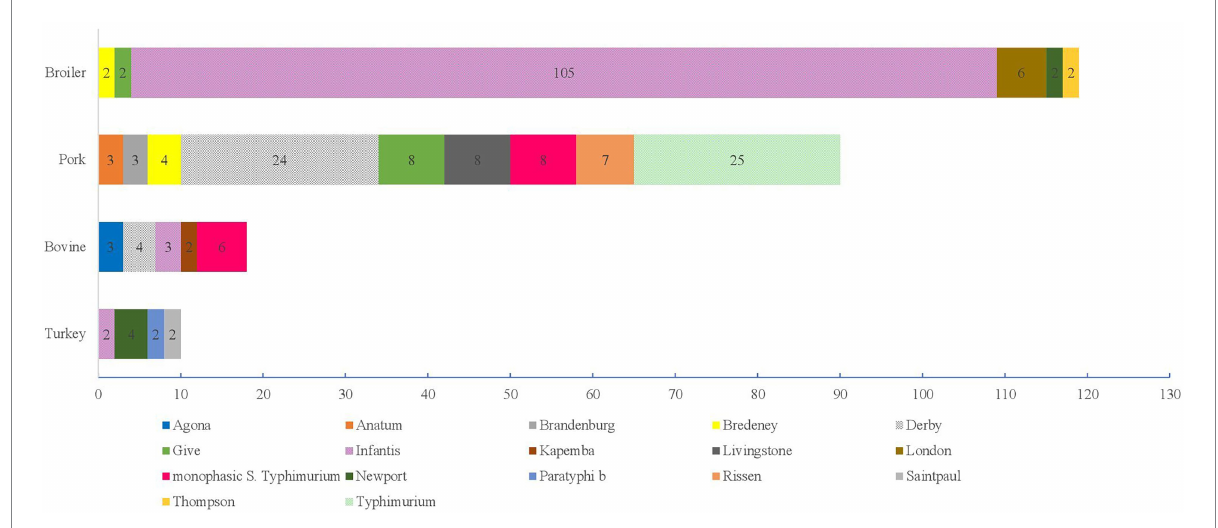
FIGURE 2 Number of Salmonella serovars within the subspecies enterica with an occurrence >1 from 2011 to 2021 isolated from Broilers, Pork, Bovine and Turkey.